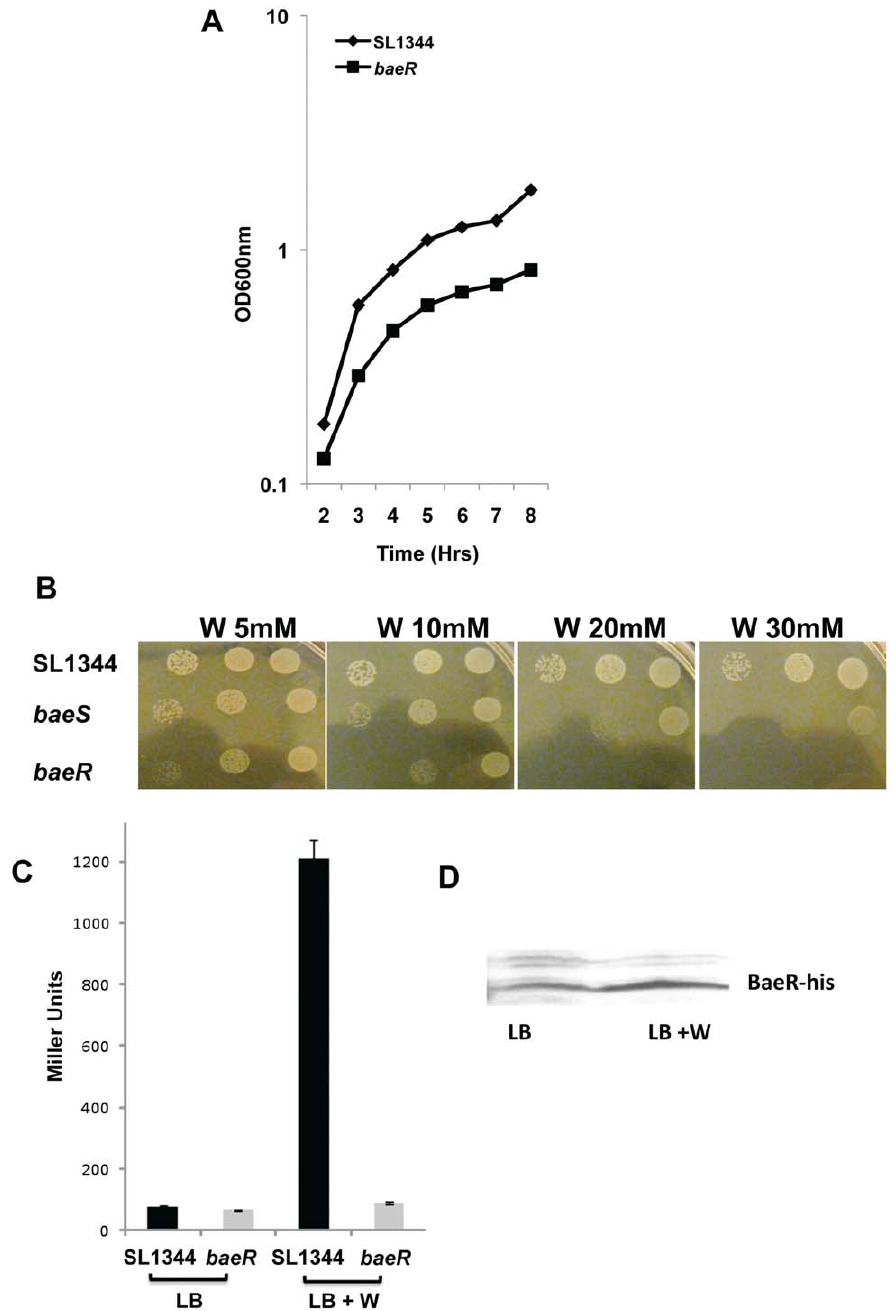
Figure 5.The growth of a baeR mutant is impaired on media containing tungstate and mdtA induction is BaeR dependent. Panel A: growth curve of SL1344 wild type and baeR mutant on LB complemented with 20mM of sodium tungstate. Panel B: SL1344 wild type, baeS and baeR mutant spotted on LB containing increasing concentrations on sodium tungstate (W). Panel C: b -galactosidase activities of the plasmid containing the mdtA promoter region fused with the promoter-less lacZ gene in a wild type (black columns) or baeR mutant (grey columns) background on LB or LB complemented with 20mM of sodium tungstate. Panel D: Immunoblot of BaeR-6His of Salmonella grown in LB with or without sodium tungstate. doi:10.1371/journal.pone.0023713.g005 (figure 5C). This is the first environmental stress identified where BaeR is both induced and required for cell viability. We also tested a range of gallic acid concentrations in similar experiments.